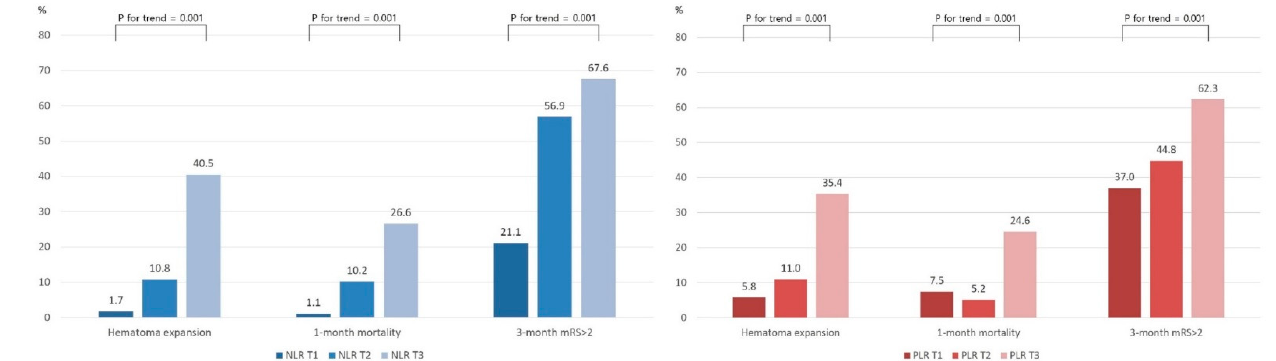
Figure 2. Comparing clinical outcomes according to NLR and PLR tertiles. Abbreviation: NLR, neutrophil–lymphocyte ratio; PLR, platelet–lymphocyte ratio; mRS, modified Rankin Scale; T1, lowest tertile; T2, middle tertile; T3, highest tertile.